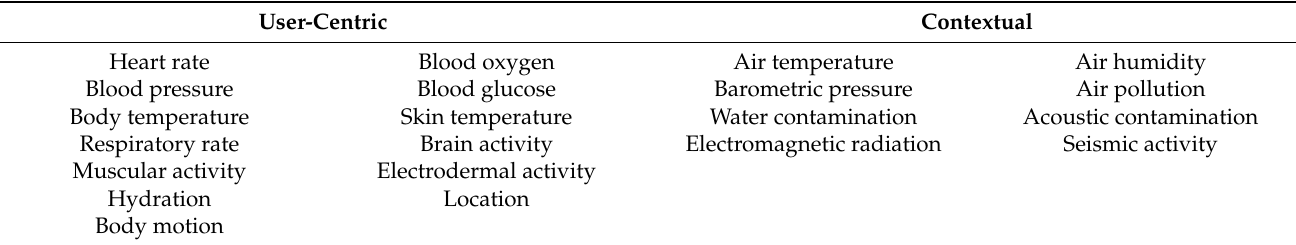
Table 1. Taxonomy of the attributes to be considered for smart